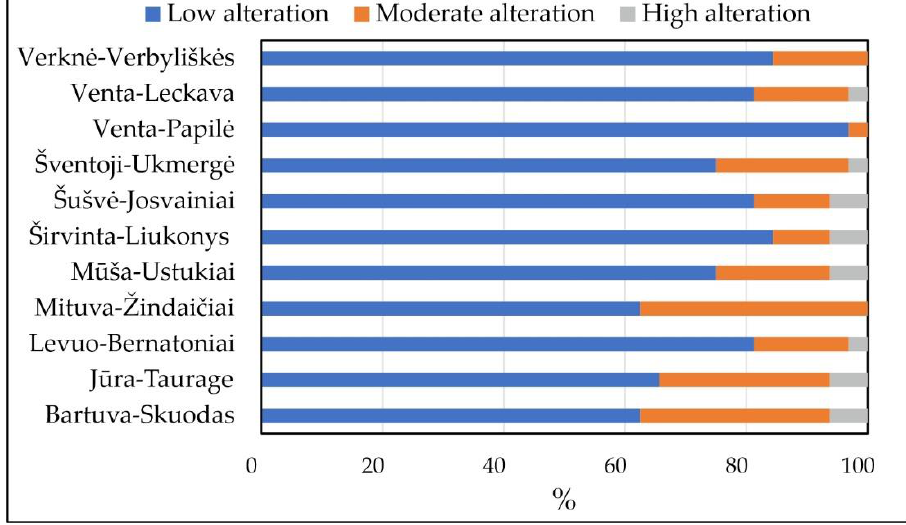
Figure 12. The overall degree (%) of hydrologic alterations.